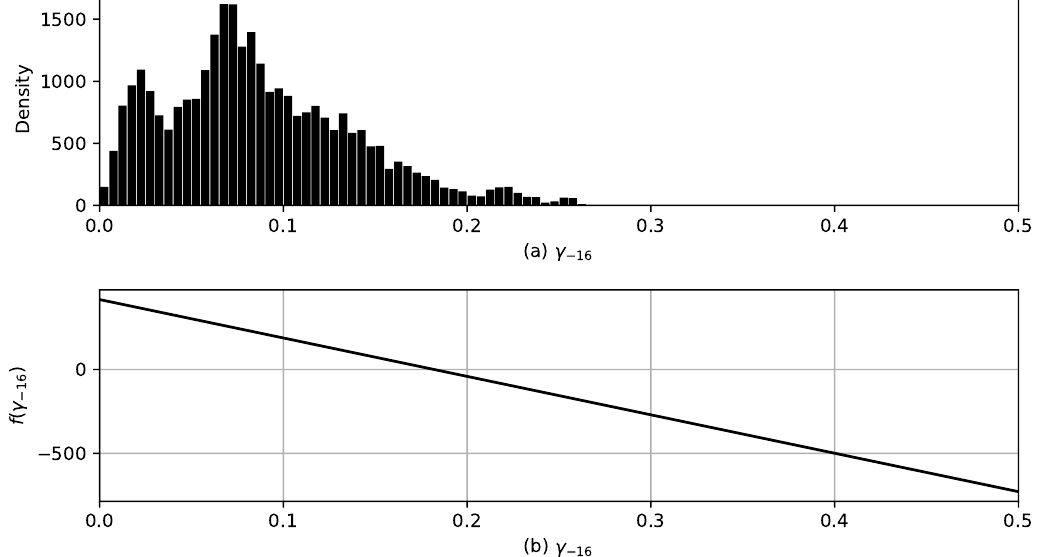
Figure 12. ( a ) Distribution of γ − 16 computed over pixels located in the green polygon at Figure 5b. ( b ) Discriminant function (Equation (6)) calibrated from the one-class SVM method. To evaluate the performance of the classifiers calibrated using the EM and the one-class SVM methods, pixels within the area delineated by GSI at Mabi town and pixels within the NF-area are used as reference pixels of flooded and non-flooded agriculture areas. A proper evaluation requires the same amount of samples for each class. Thus, 10,000 pixels are extracted randomly from each of the referred areas. Three scores are used for the evaluation: producer accuracy (PA), user accuracy (UA), and F1. The PA represents the percentage of samples extracted from the GSI-area (NF-area) that were classified as flooded (non-flooded). Similarly, the UA is the percentage of samples classified as flooded (non-flooded) that were extracted from the GSI-area (NF-area). The F1 is computed from the following expression, 2 ( UA − 1 + PA − 1 ) − 1 . To consider the effect of the random sampling, the evaluation was performed a hundred times. Figure 14 reports the resulting scores. It is observed all the scores have the value of ~81%, which indicates high accuracy. Table 1 reports the predictions over the all pixels in the GSI-area, the surveyed paddy fields, and the